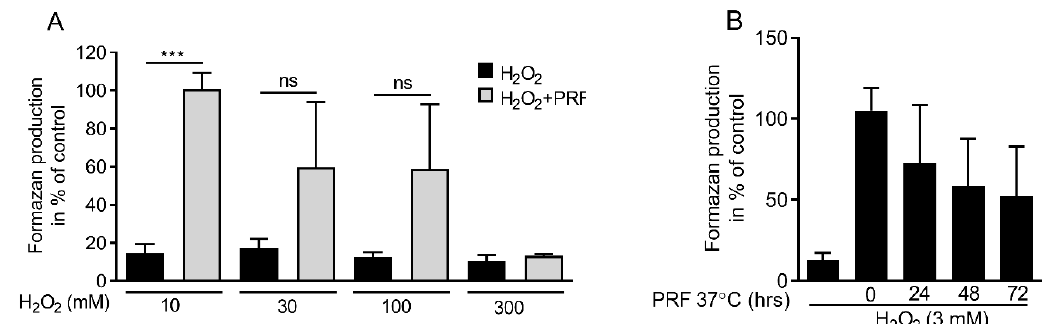
Figure 5. PRF capacity in neutralizing hydrogen peroxide is dose-dependent. ( A ) Gingival fibroblast cells were exposed to PRF lysates in the presence of various doses of H 2 O 2 (10, 30, 100, 300 mM). MTT results confirmed cell viability in the presence of PRF lysates for all the groups except 300 mM. ( B ) The neutralizing capacity of PRF lysates incubated at 37 °C for 24, 48, and 72 h were also tested in the presence of 3 mM H 2 O 2 . The results suggest that catalase activity was decreased in a time-dependent manner. n = 3–5. Data represent the mean ± SD. *** p < 0.001 and ns = not significant, by two-tailed Mann–Whitney test.